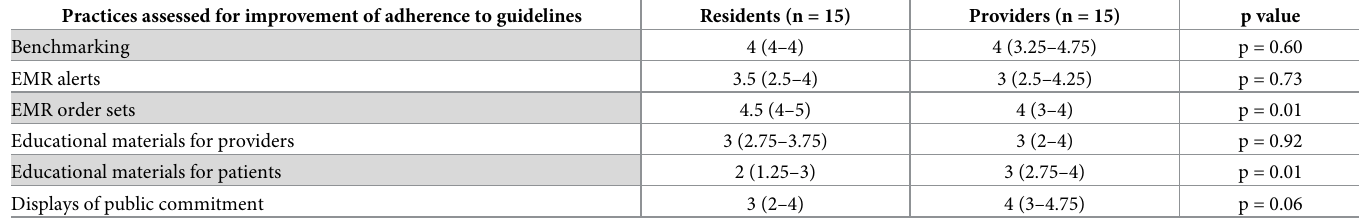
Table 1. Median 5-point Likert scale